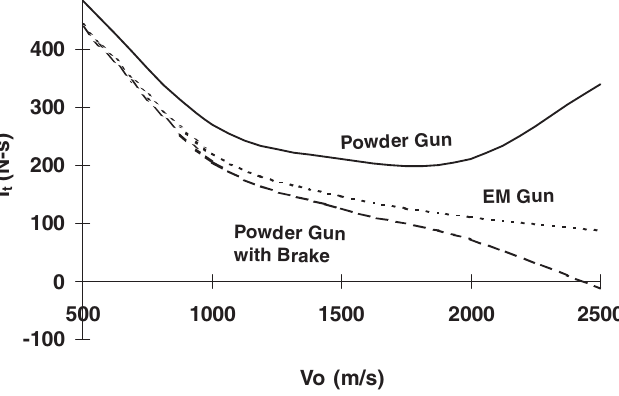
Fig. 6. Muzzle brake efficiencies.